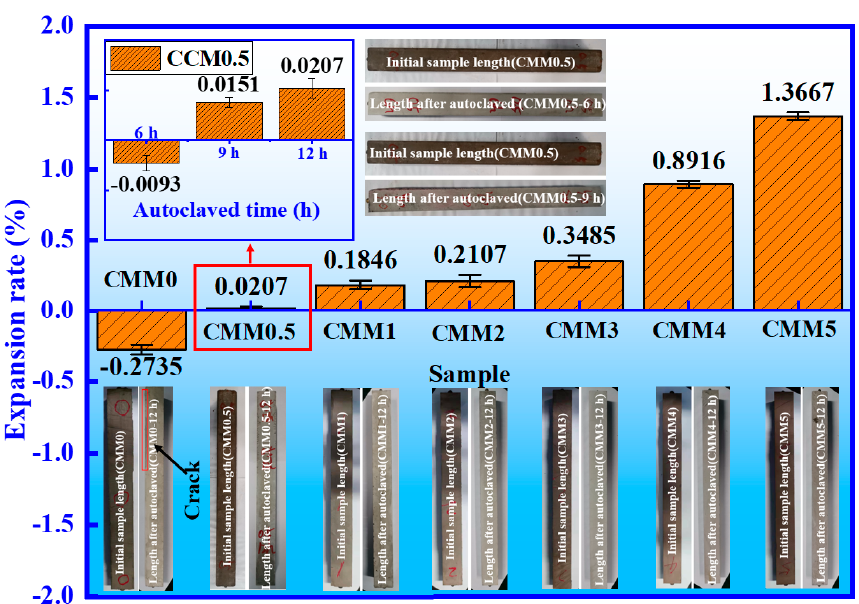
Figure 9. The expansion rates of CMM ‐ 12 h and CMM0.5 at different autoclaved times. Table 4. CMM autoclaved test parameters.